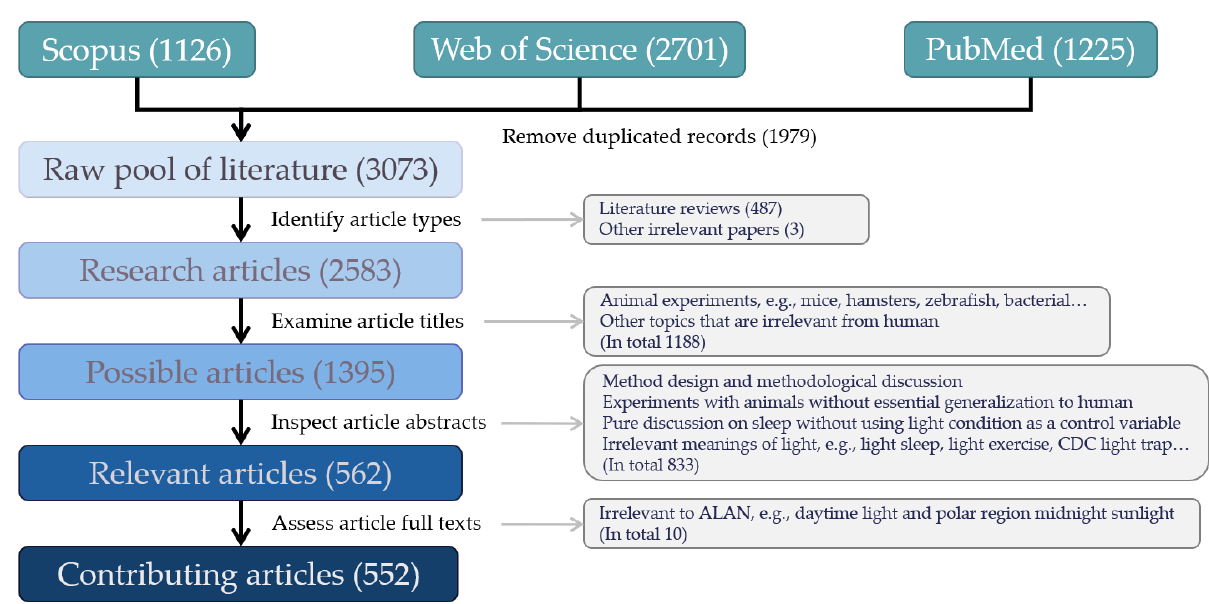
Figure 1. Flow chart of the article screening scheme.